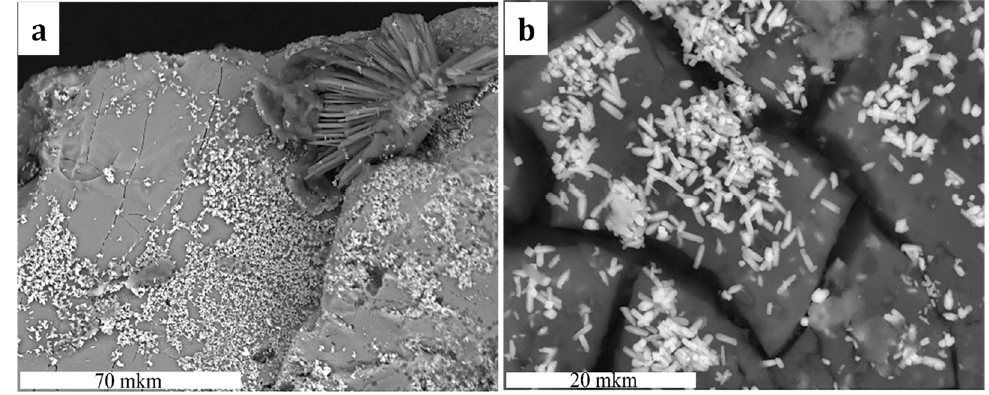
Figure 2. Secondary phases (celestite SrSO 4 ( a ) and gypsum CaSO 4 •2 Н 2 O ( b )) in the residues of the leachate.